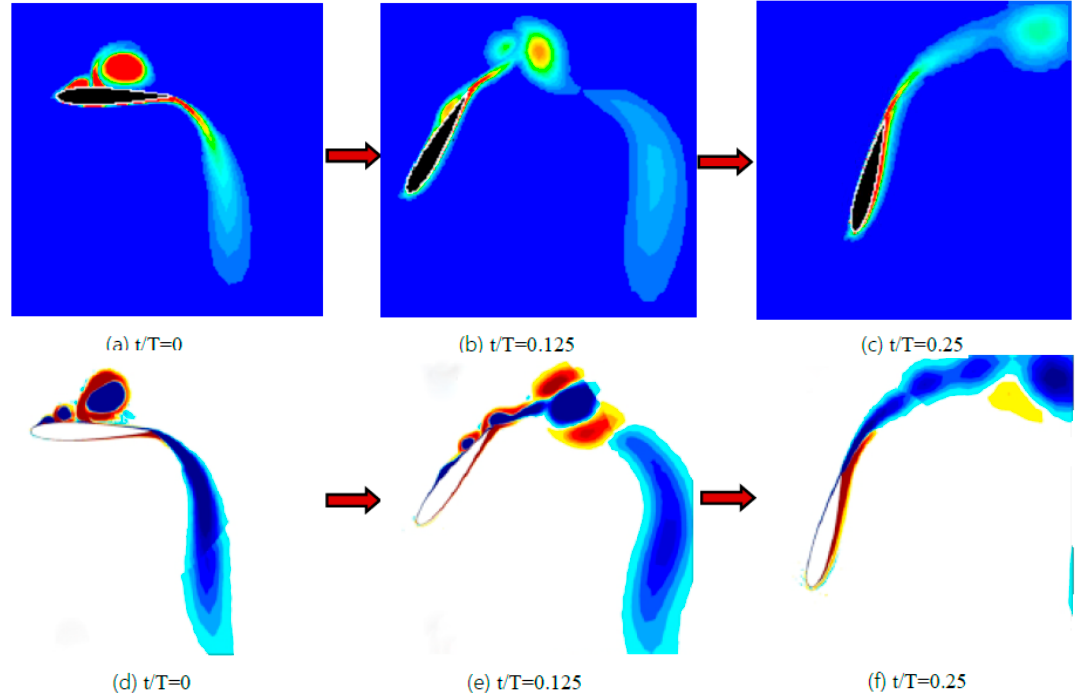
Figure4. Comparison ofthe vorticity fieldsbetween the simulation model of this paperand Reference[8] Figure 4. Comparison of the vorticity fields between the simulation model of this paper and Reference at f * = 0.14. ( a – c ) The vorticity fields of the simulation model in this paper. ( d – f ) The vorticity fields of [8] at f * = 0.14. ( a, b, c ) The vorticity fields of the simulation model in this paper. ( d, e, f ) The vorticity Reference [8]. fields of Reference [8].